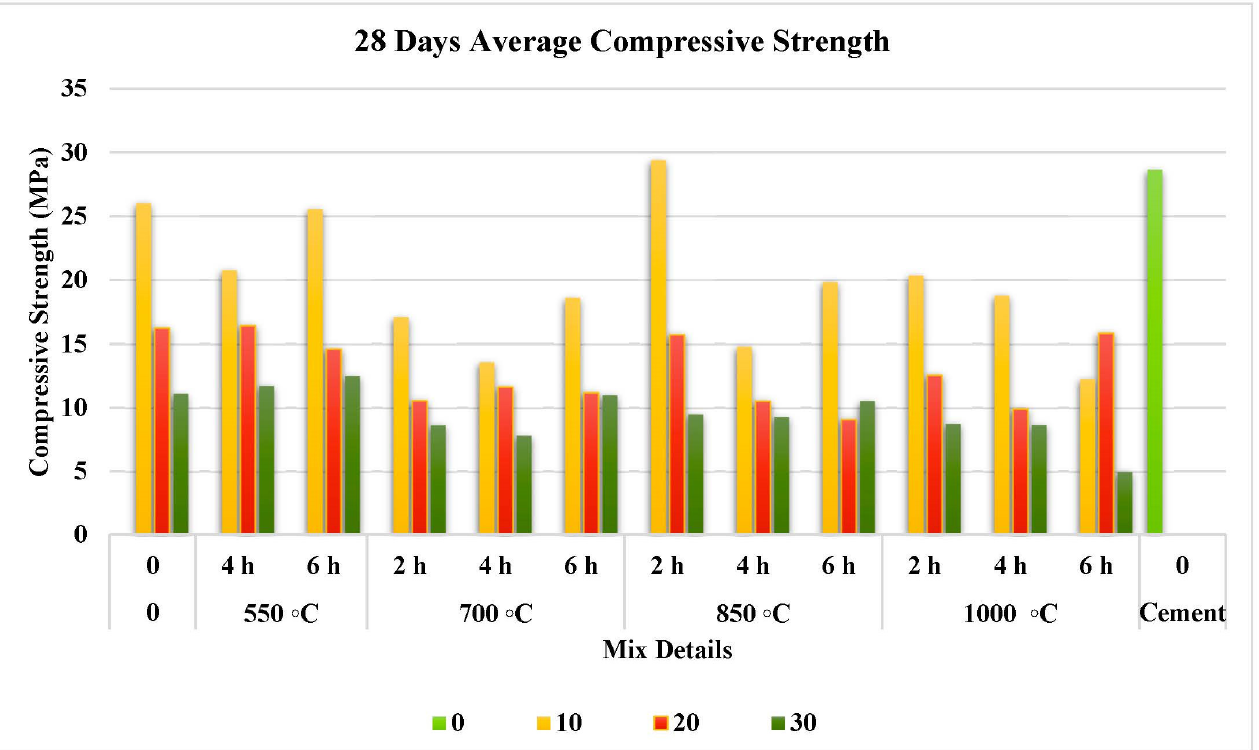
Figure 8. Effect of pre-treatment on 28 day compressive strength.